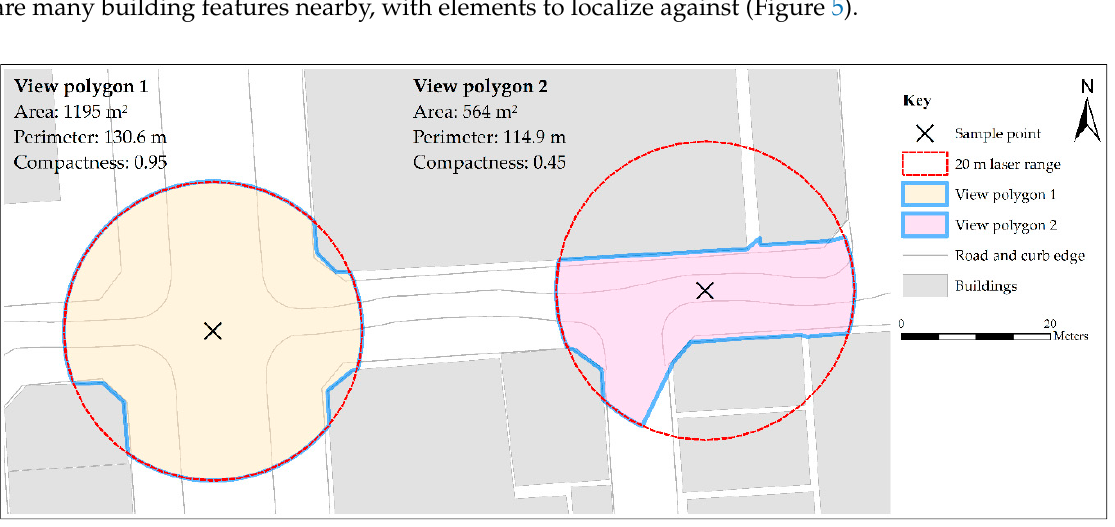
Figure 5. Two different view polygons and their respective area, perimeter and